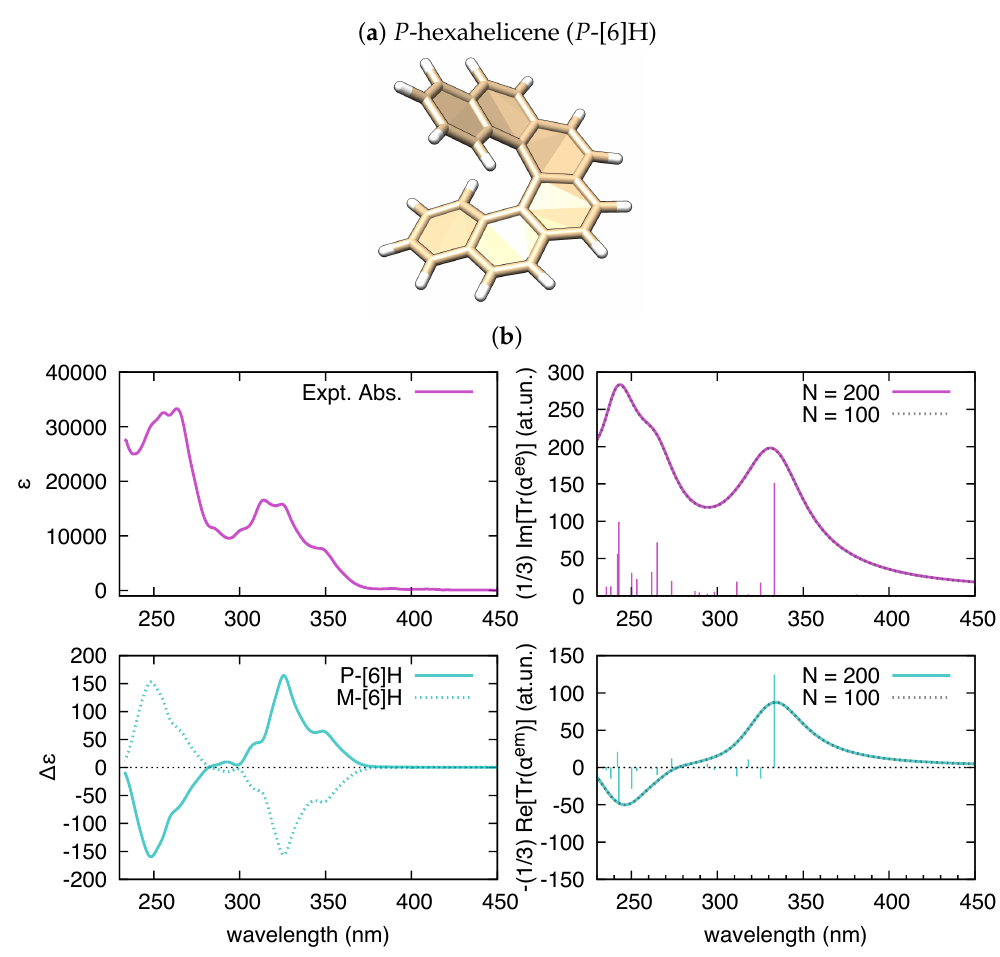
Figure 3. ( a ) Graphical representation of the equilibrium structure of P -hexahelicene (data from B3LYP/6-31G(d,p) DFT calculation); and ( b ) comparison of the experimental UV-Vis absorption of hexahelicene and the electronic circular dichroism(ECD) spectra of P -hexahelicene and M -hexahelicene (from [60]) vs. the corresponding spectra simulated by polar ( Γ = 0.5 eV) based on results from TDDFT calculations (200 states,